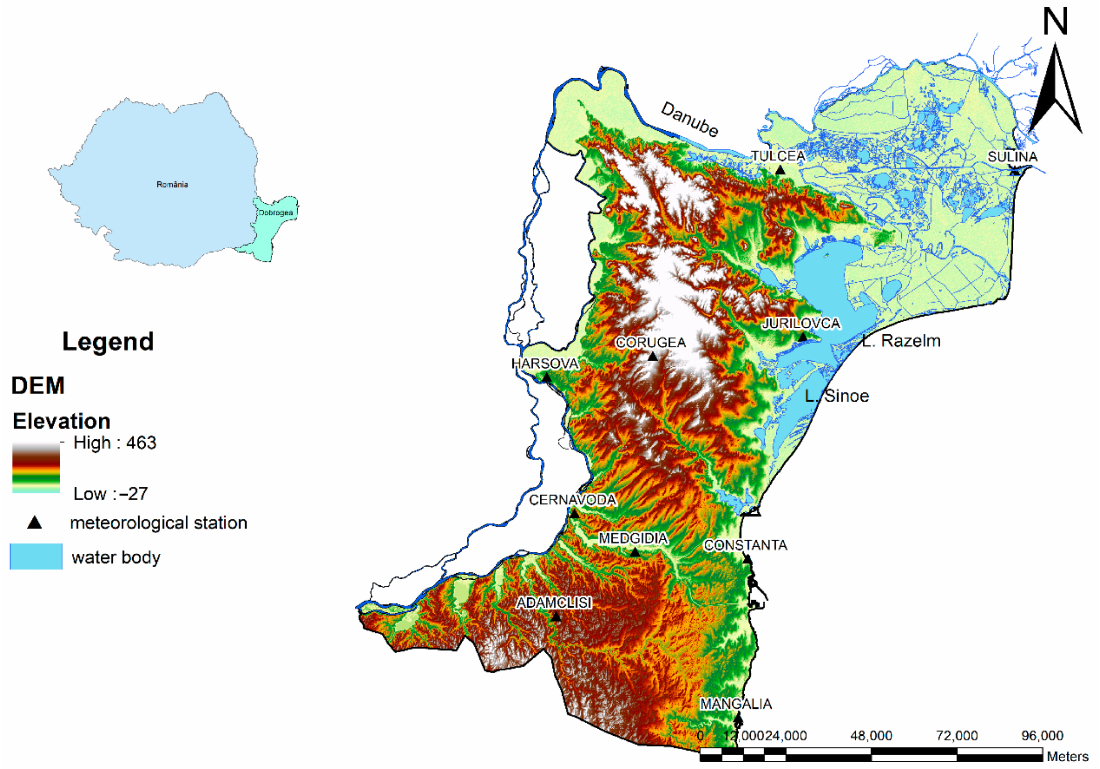
Figure 2. The map of the Dobrogea region (DEM: Digital Elevation Model). From a hydrological viewpoint, Dobrogea is divided into two basins, one tributary to the Danube River and the other tributary to the Black Sea basin. According to the Management Plan of Dobrogea-Littoral Watershed, the total length of rivers in Dobrogea is 1623 km of rivers; there are 18 lakes and four reservoirs. Wetland areas represent 23% of the